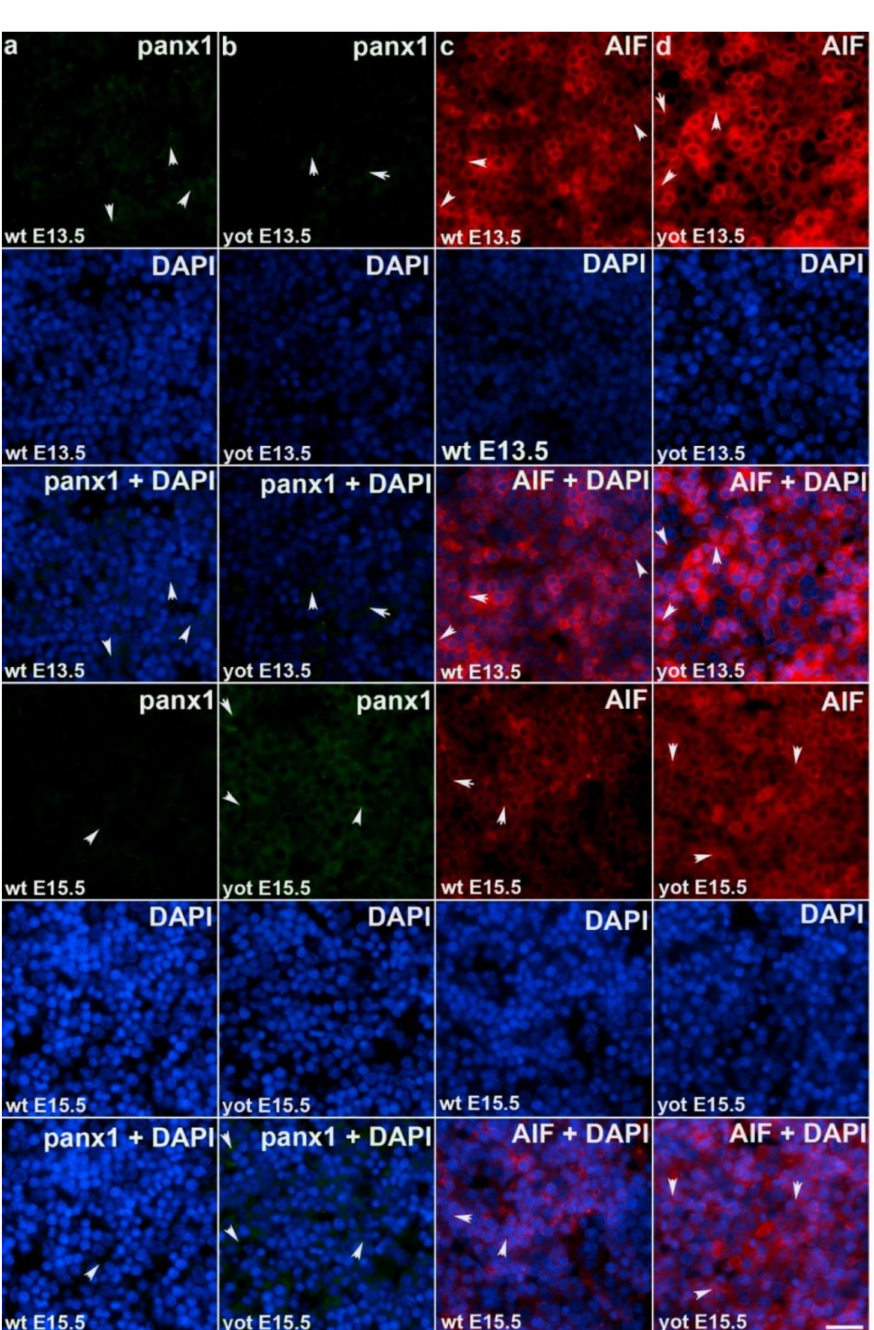
Figure 5. Immunofluorescence staining of pannexin1 (Panx1) and apoptosis-inducing factor (AIF) in wild type and yotari mouse liver at gestation days E13.5 and E15.5. Immunoexpression of Panx1, 4 (cid:48) ,6-diamidino-2-phenylindole dihydrochloride (DAPI) staining and merged Panx1 and DAPI at E13.5 and E15.5 in wild type ( a ) and yotari ( b ). Immunoexpression of AIF, DAPI staining and merged AIF and DAPI at E13.5 and E15.5 in wild type ( c ) and yotari ( d ). The scale bar is 8 µ m, refers to all